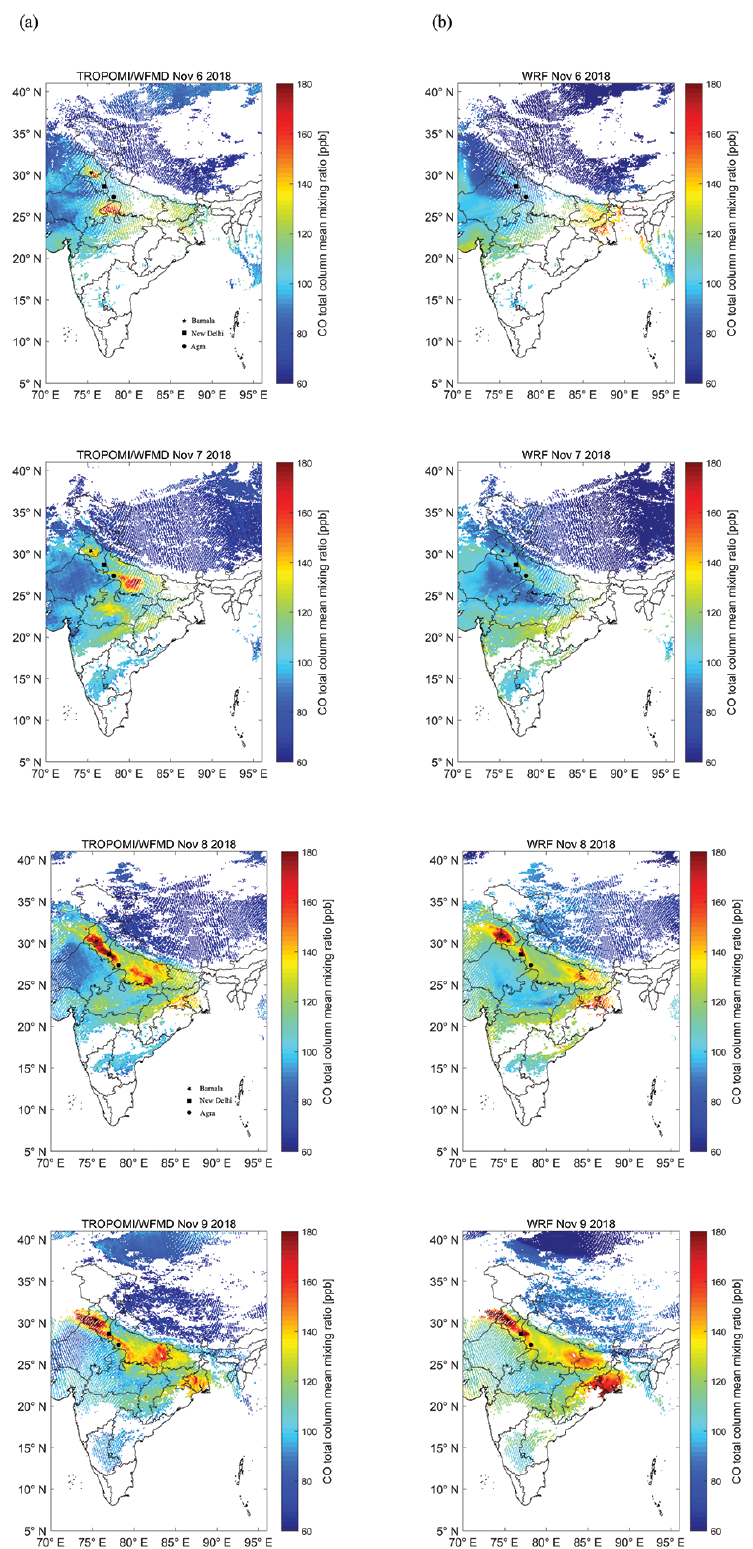
Figure 5. (a) Daily column CO observations from TROPOMI/WFMD and (b) the co-located WRF simulation for 6–9 November 2018.